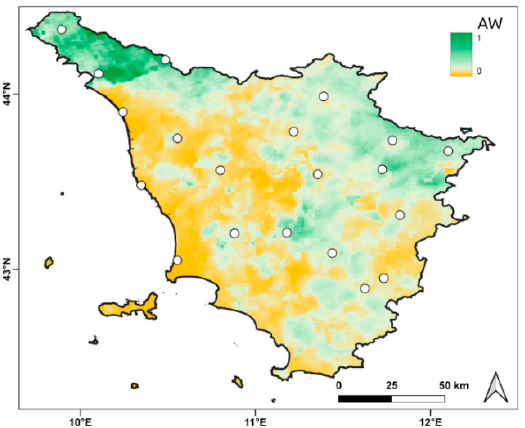
Figure 5. AW map of Tuscany obtained using the combined dataset for July–August 2021, with position of the 20 weather stations considered (white dots).